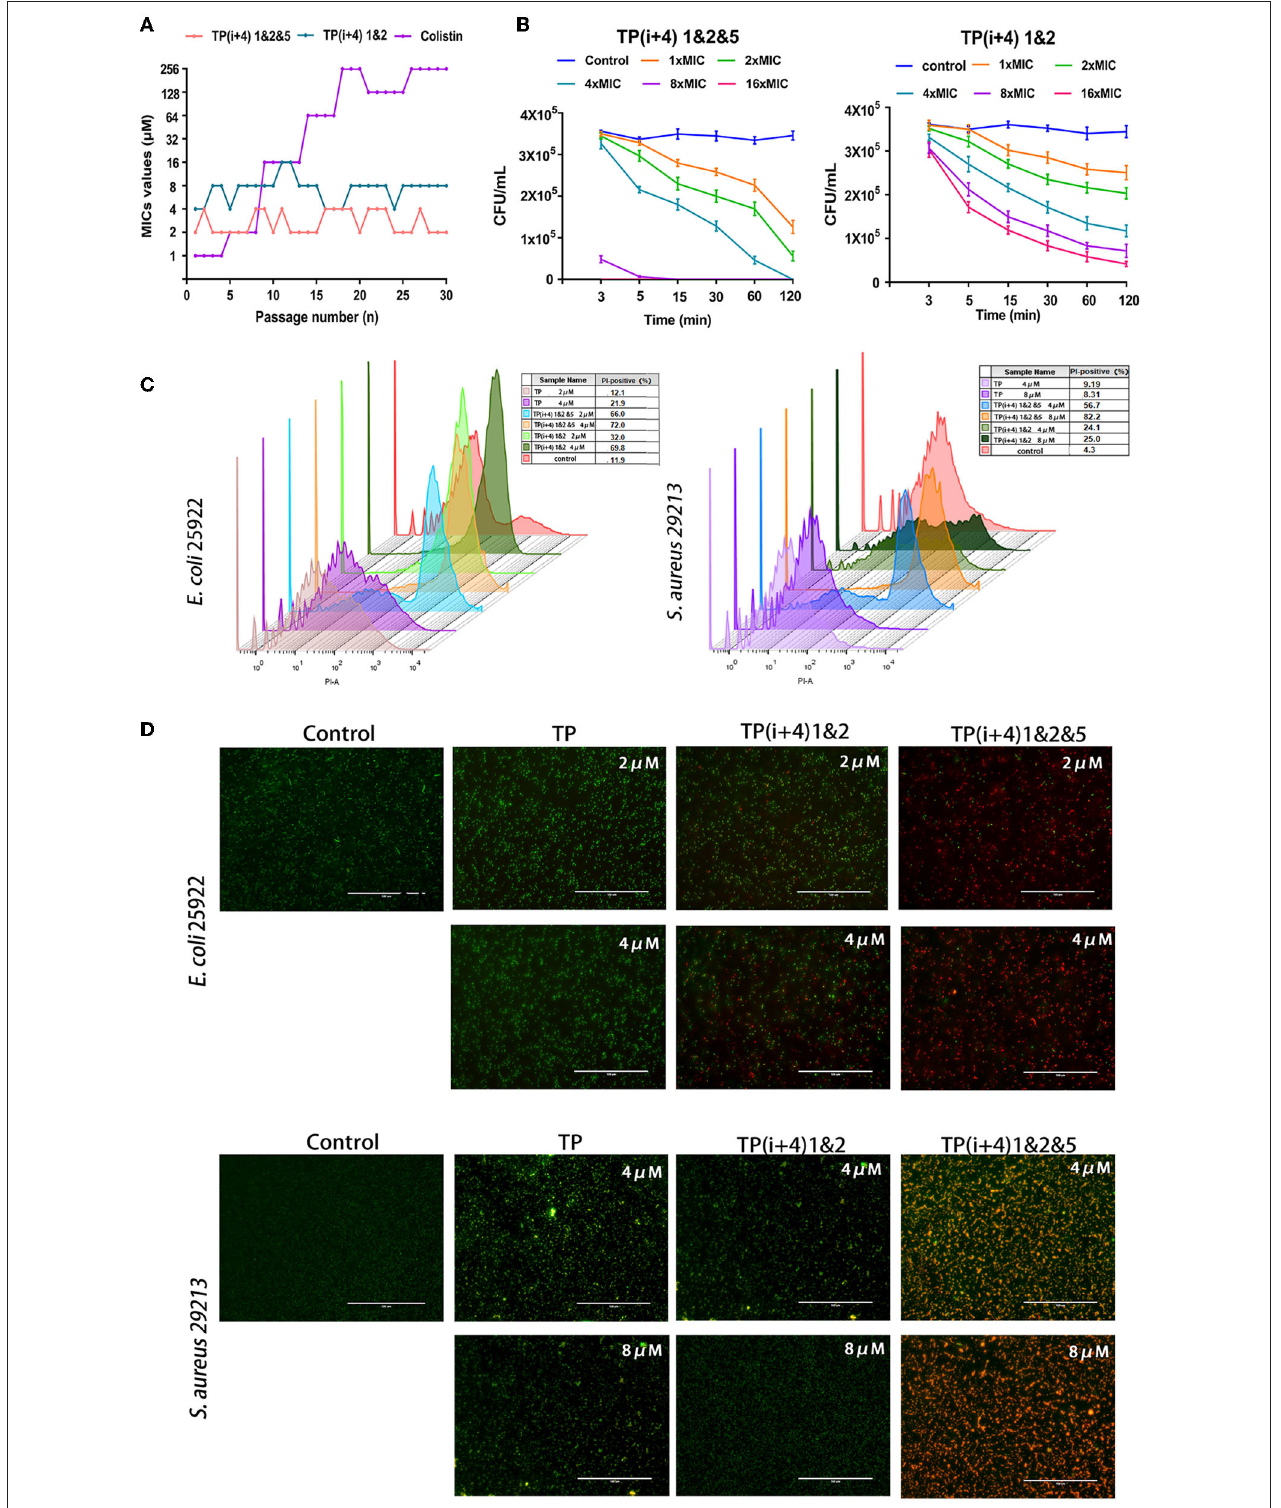
FIGURE 4 | (A) Resistance developments in the presence of a sub-MIC concentration of peptides TP(i + 4) 1&2, TP(i + 4) 1&2&5, and colistin. (B) Bactericidal kinetics of TP(i + 4) 1&2&5 and TP(i + 4) 1&2 against E. coli 25922; (C) FCM was used to analyze the damage of peptide to bacterial membrane. (D) Fluorescence microscopy, green signal: SYTO 9, red signal: